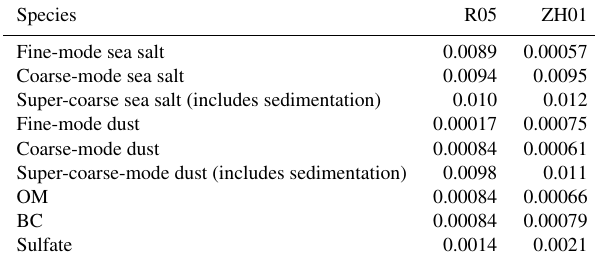
Table 9. The 2014 global average of dry deposition velocities com- puted with R05 and ZH01 (ms − 1